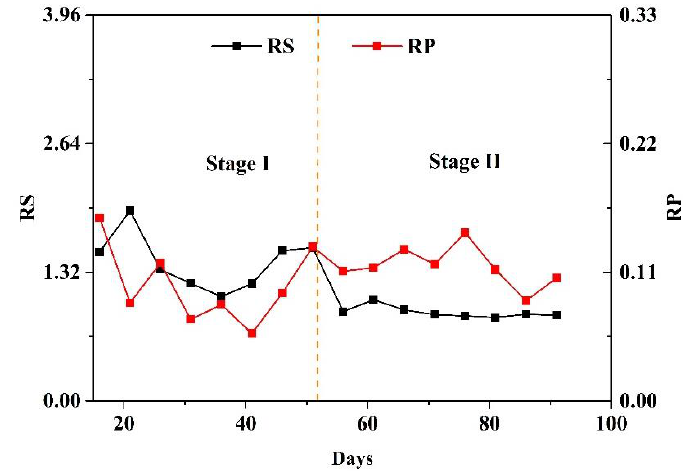
Figure 3. RS and RP value in the MBBR. Note: RS: consumption of nitrite/ammonium; RP: increase of nitrate/consumption of nitrite + ammonium.